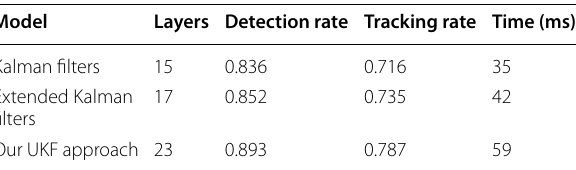
Table 3 A comparison of several popular algorithms with our approach